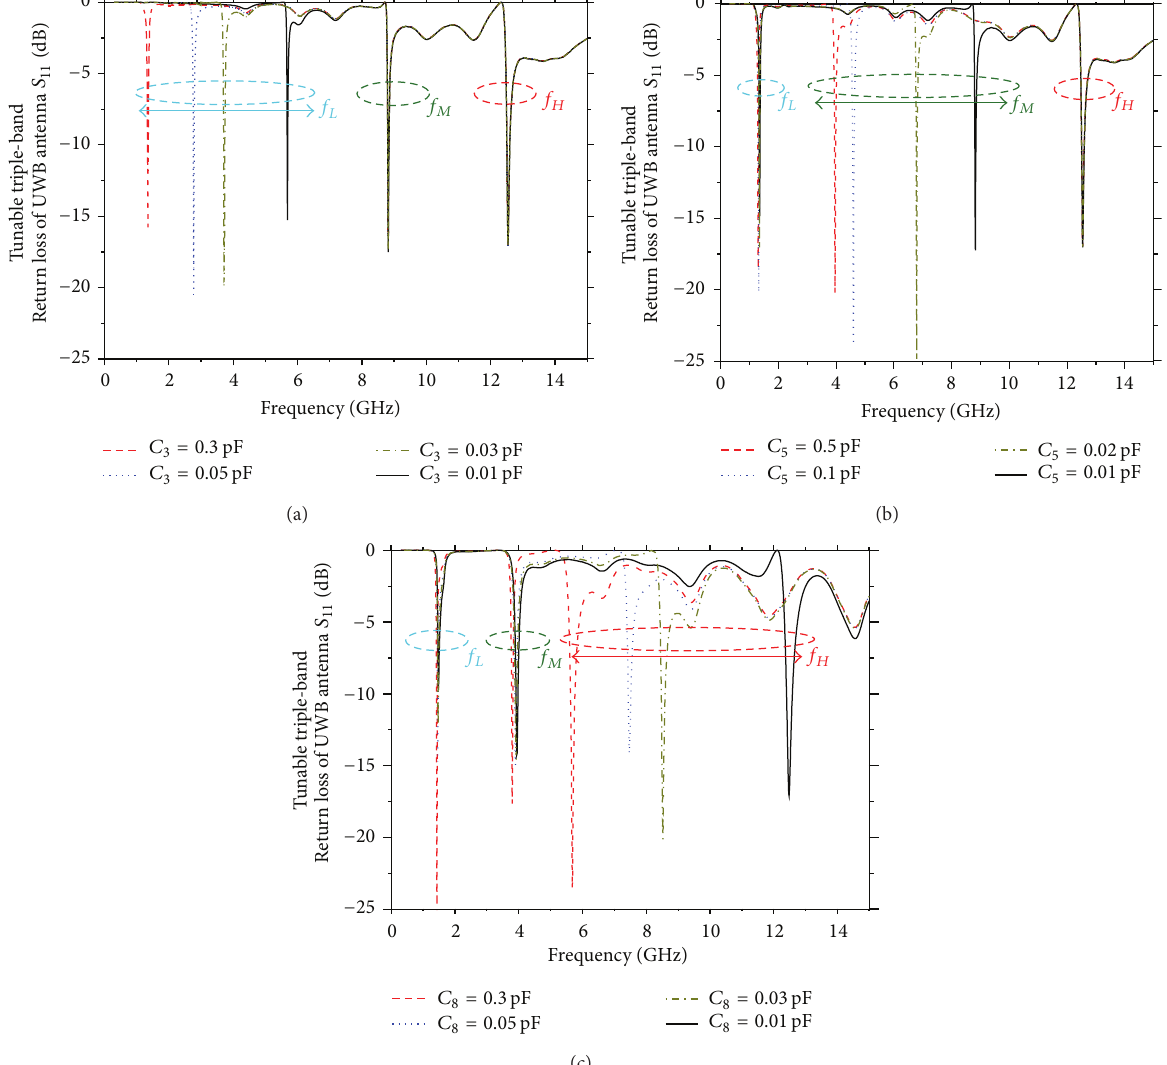
Figure 4: Independently continuous tunable multiband antennas at (a) 𝑓 𝐿 , (b) 𝑓 𝑀 , and (c) 𝑓 𝐻